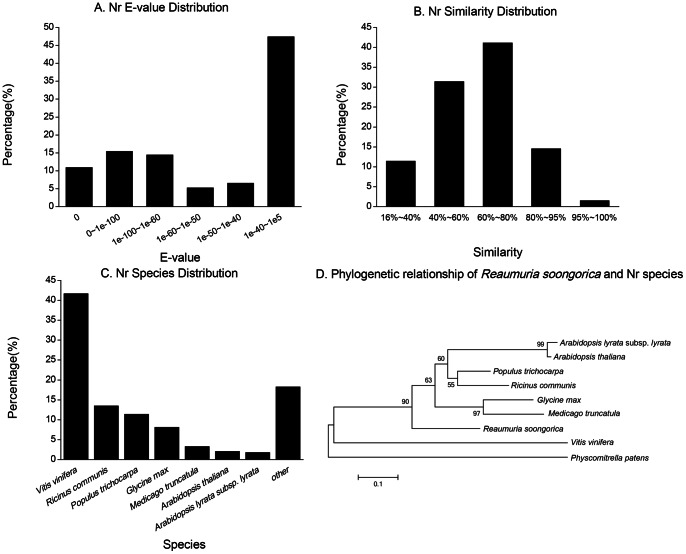
Characteristics of similarity search of unigenes against Nr databases.(A) The E-value distribution of Nr annotation results. (B) The similarity distribution of Nr annotation results. (C) The species distribution of Nr annotation results. (D) The phylogenetic relationship of Reaumuria soongorica and Nr species. Phylogenetic tree constructed by the Neighbor-Joining method for the internal transcribed spacer (ITS) sequences. Physcomitrella patens was included as an out-group. Neighbor-Joining was consensus tree used 1000 bootstrap replicates. The number represents the percentage of bootstrap values.